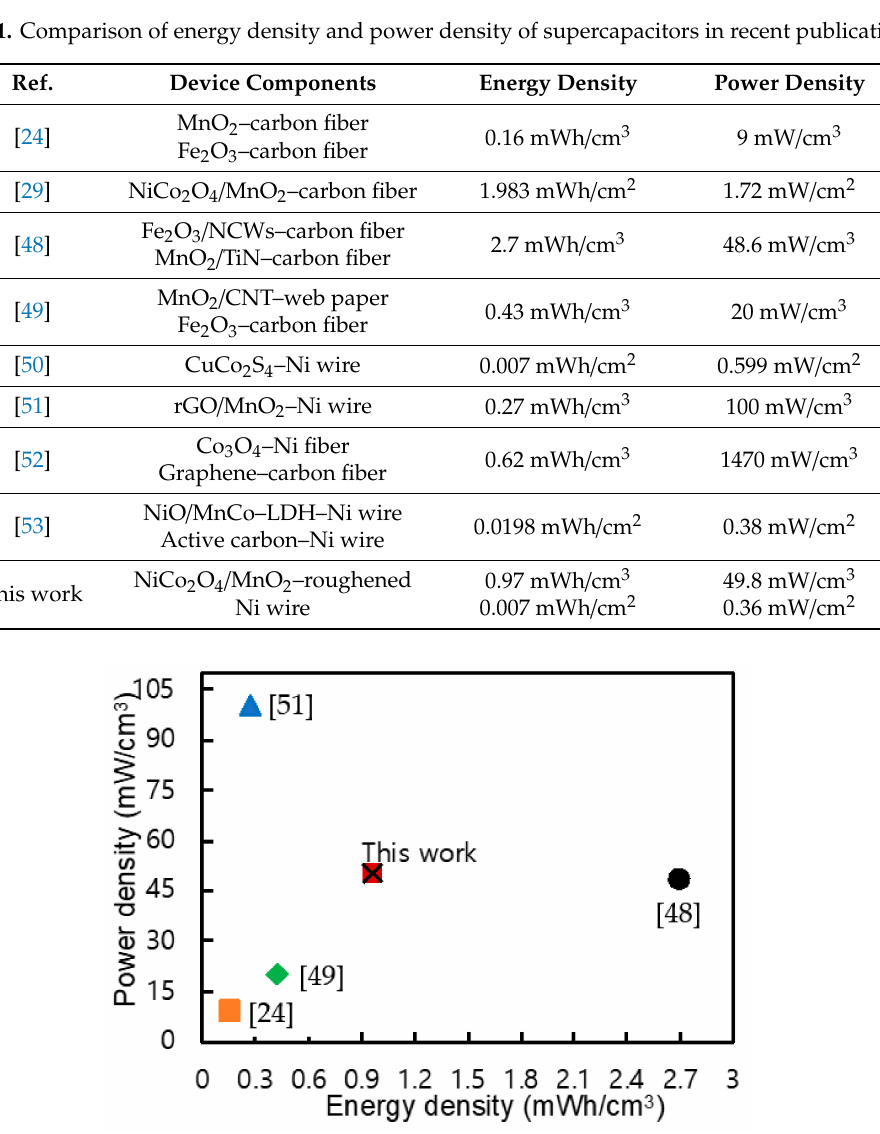
Figure 13. Ragone plot of supercapacitors in recent publications.